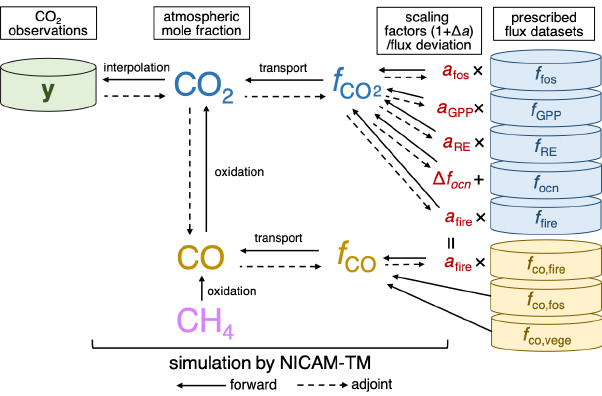
Figure 2. Schematic diagram of the CO 2 –CO forward/adjoint cal- culations in